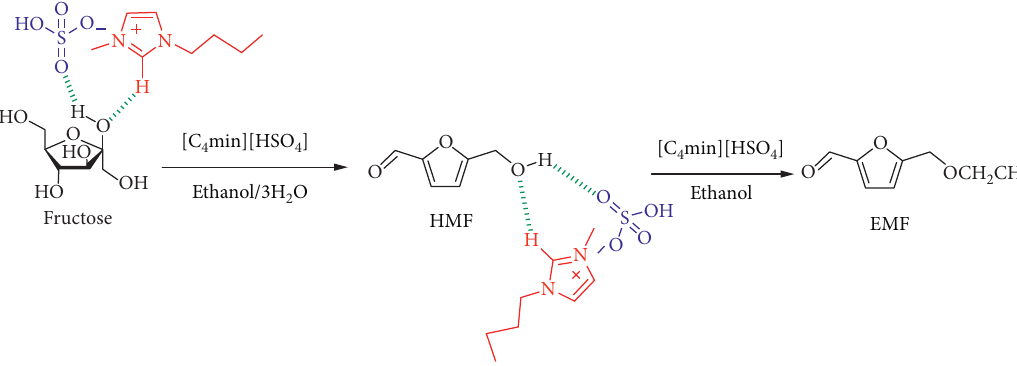
Scheme 4: The conversion of fructose to EMF catalyzed by [C